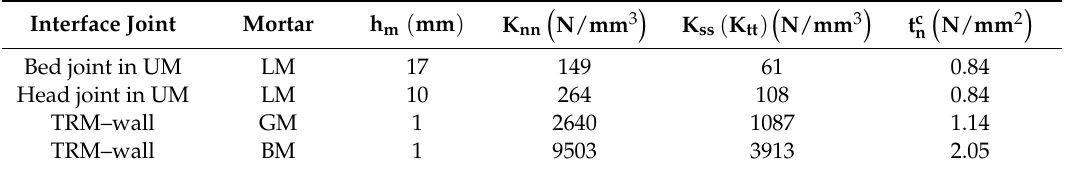
Table 12. Parameters of interface joint